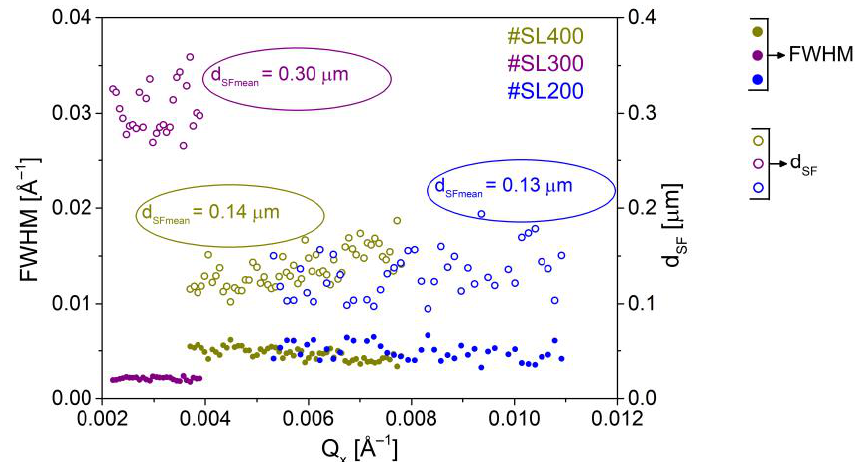
Figure 7. The full width at half maximum (FWHM) of diffuse scattering streak from the stacking faults (full circles, left vertical axis); Diameters of stacking faults calculated using FWHM (open circles, right vertical axis).